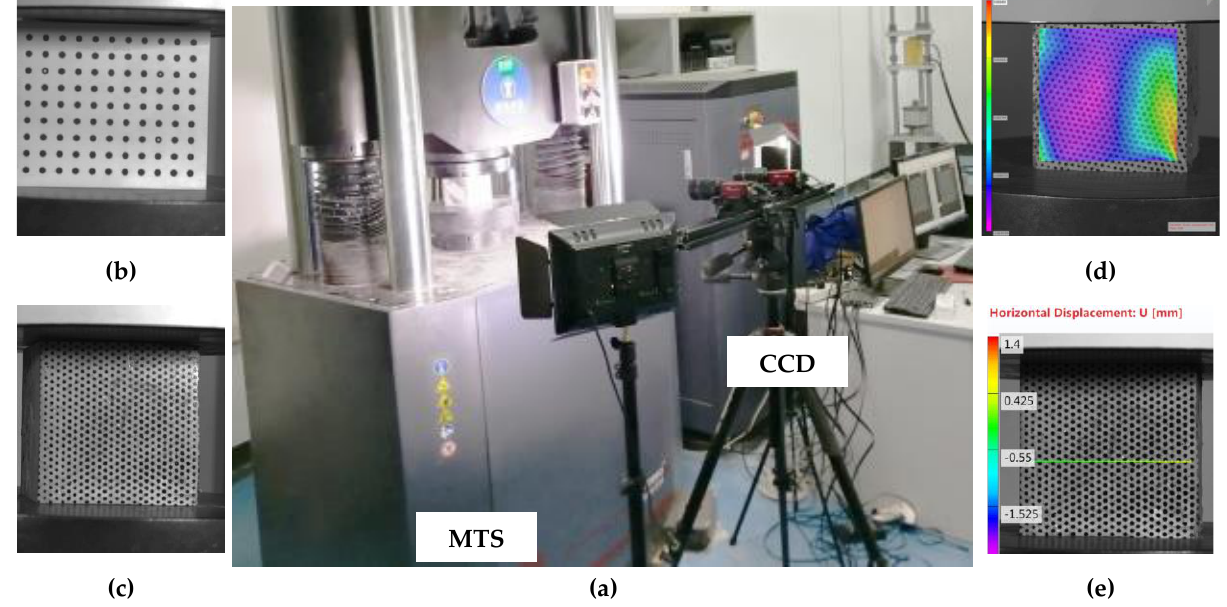
Figure 1. Test setup ( a ) MTS pressure testing machine and industrial camera test system ( b ) Camera parameter correction ( c ) Sample speckle ( d ) Area of surface analysis ( e ) Area of line